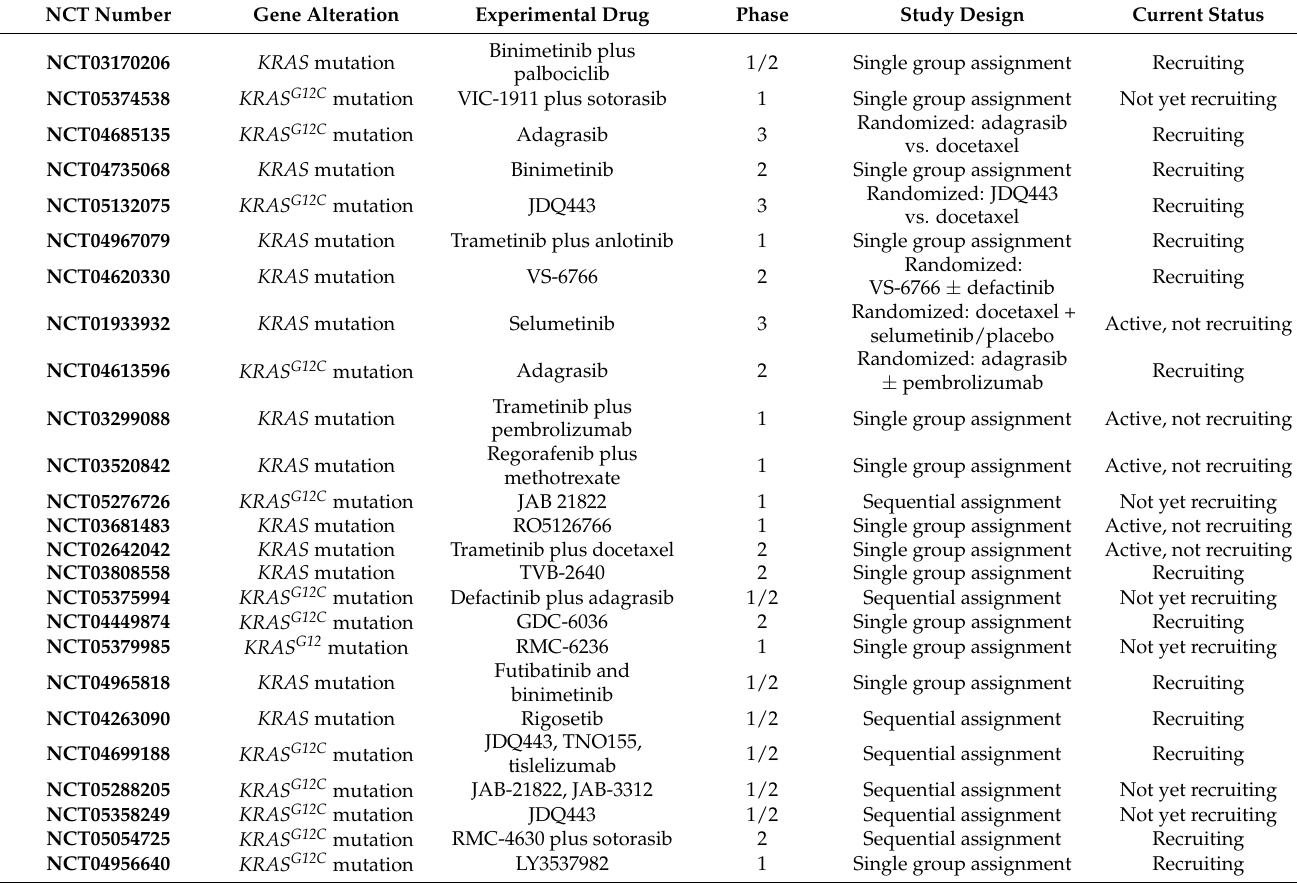
Table 4. Trials testing novel agents or combination strategies for KRAS mutant